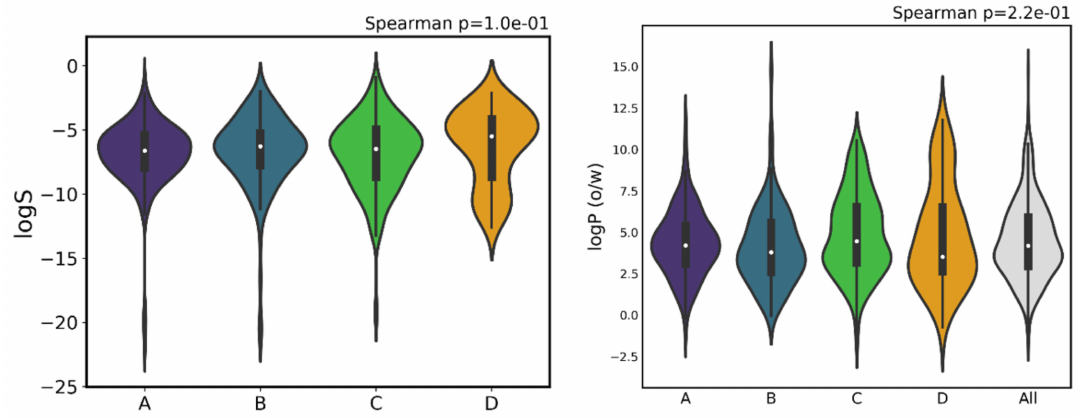
Figure 14. Distribution of logS (left) and logP(o / w) (right) across the di ff erent activity